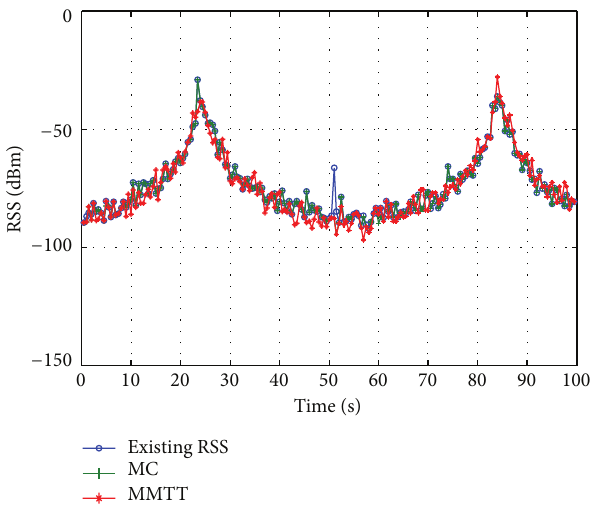
Figure 13: Received signal strength with FRR3.